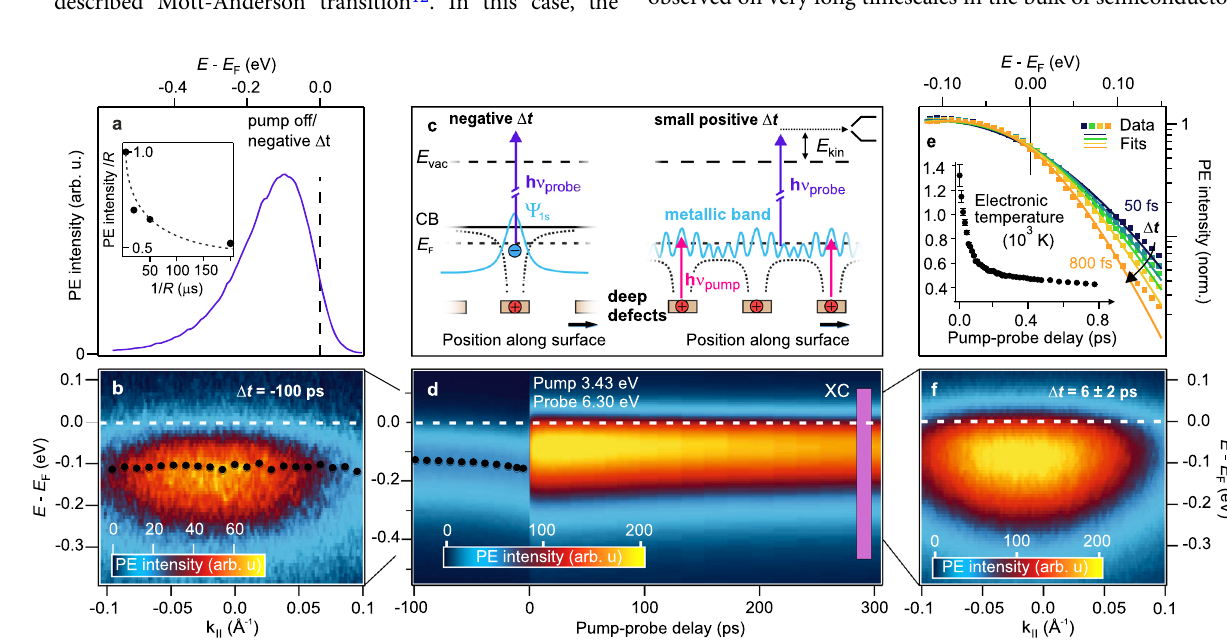
Fig. 1 Time-resolved photoelectron spectroscopy of the ZnO(10 – 10) surface upon resonant excitation. a Angle-integrated photoelectron (PE) spectra recorded with h ν probe = 6.3 eV with the pump laser pulse h ν pump = 3.43 eV off or at negative pump-probe delays Δ t . Inset: Repetition rate dependency of the signal. The dashed line is a guide to the eye. b Angle-resolved PE spectrum at negative pump-probe delays showing a dispersionless feature. Black dots: Peak maximum of the intensity distribution. c Energy level diagram and illustration of the discussed surface metal generation due to the photoexcitation of deep defects at the ZnO surface. Negative delays: Photodoped semiconductor due to long-lived defect excitons. Small positive delays: Formation of a metallic band. d Temporal evolution of the PE intensity in false colors as a function of pump-probe delay Δ t and energy. Pump laser fl uence: 27 μ J/cm 2 . The pump pulse induces an abrupt increase of the electron density below E F . The purple box (XC) indicates the energy-integration window for the evaluation shown in Fig. 2a. e Normalized, angle-integrated PE intensity for different positive delays (50 – 800 fs) with Fermi-Dirac distribution fi ts (solid lines). Inset: Electronic temperature versus Δ t . Error bars represent standard deviations. f Angle-resolved PE intensity averaged from 4 to 8 ps showing a dispersive free electron-like